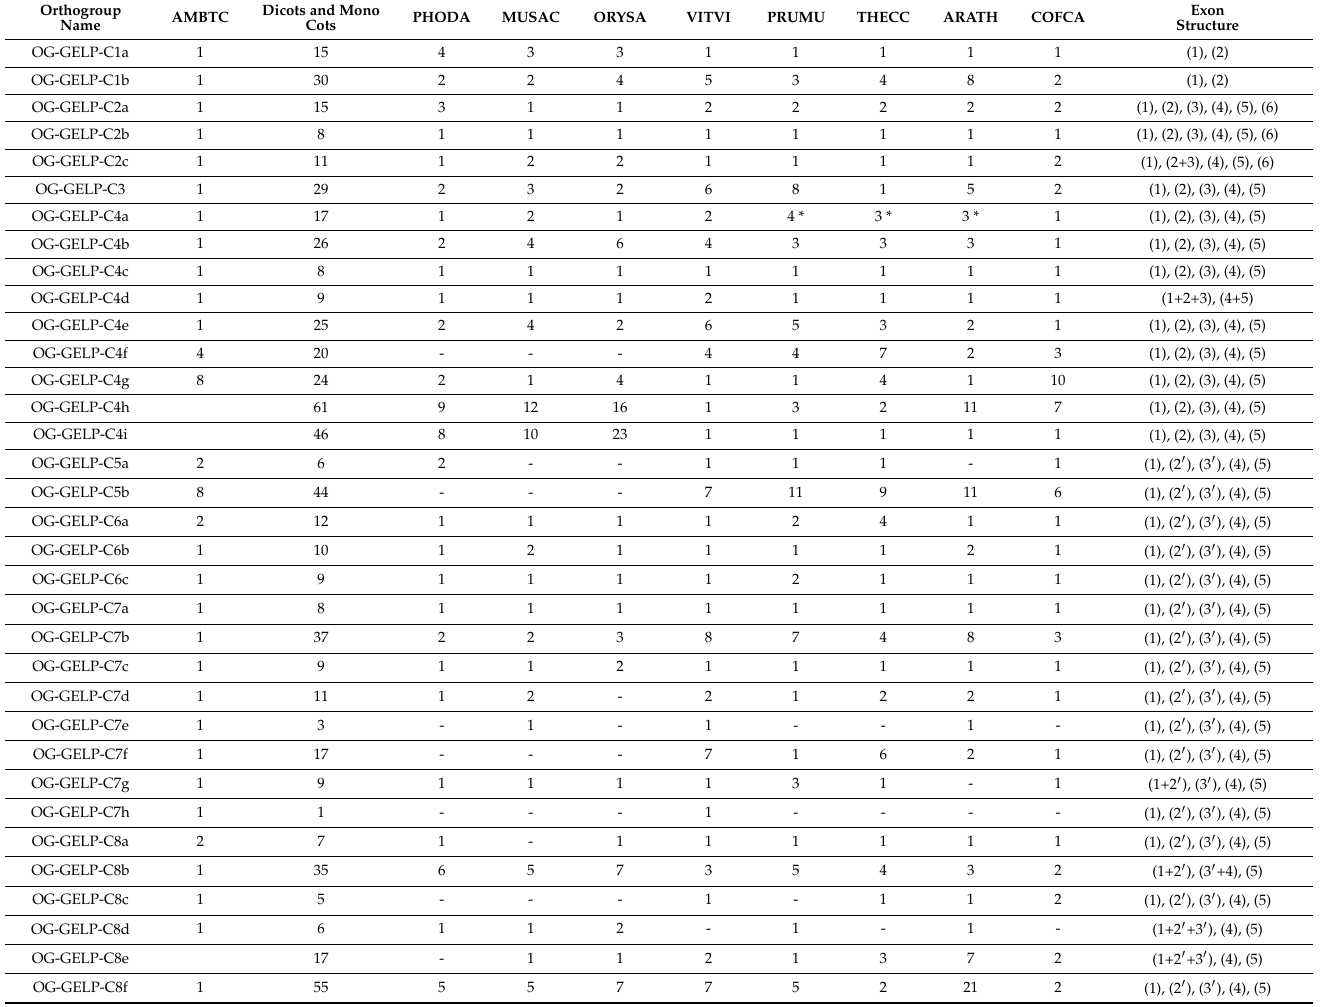
Table 3. Sequence numbers per species assigned to the established GELP OGs. Species names are represented by species codes. * Two or three sequences represent alternative splicing versions where the first exon is chosen from two (or three in P. mume ) independent regions. Independent exon structures are marked with different colors, including red for genes in OGs derived from Cluster 1, blue for Cluster 2, green for Cluster 3 and black for the remaining clusters. Exons 2 and 3, which have different junctions in sequences included in the OGs derived from Cluster 4 and Clusters 5–10, are differentiated by a prime symbol (i.e., (2 (cid:48) ) and (3 (cid:48) )). In dicots and O. sativa, the structures are (1) (2 (cid:48) + 3 (cid:48) + 4), (5). In the A. trichopoda exon, (3 (cid:48) ) is not split into two parts (1), (2 (cid:48) ), (3 (cid:48) ), (4), (5)).